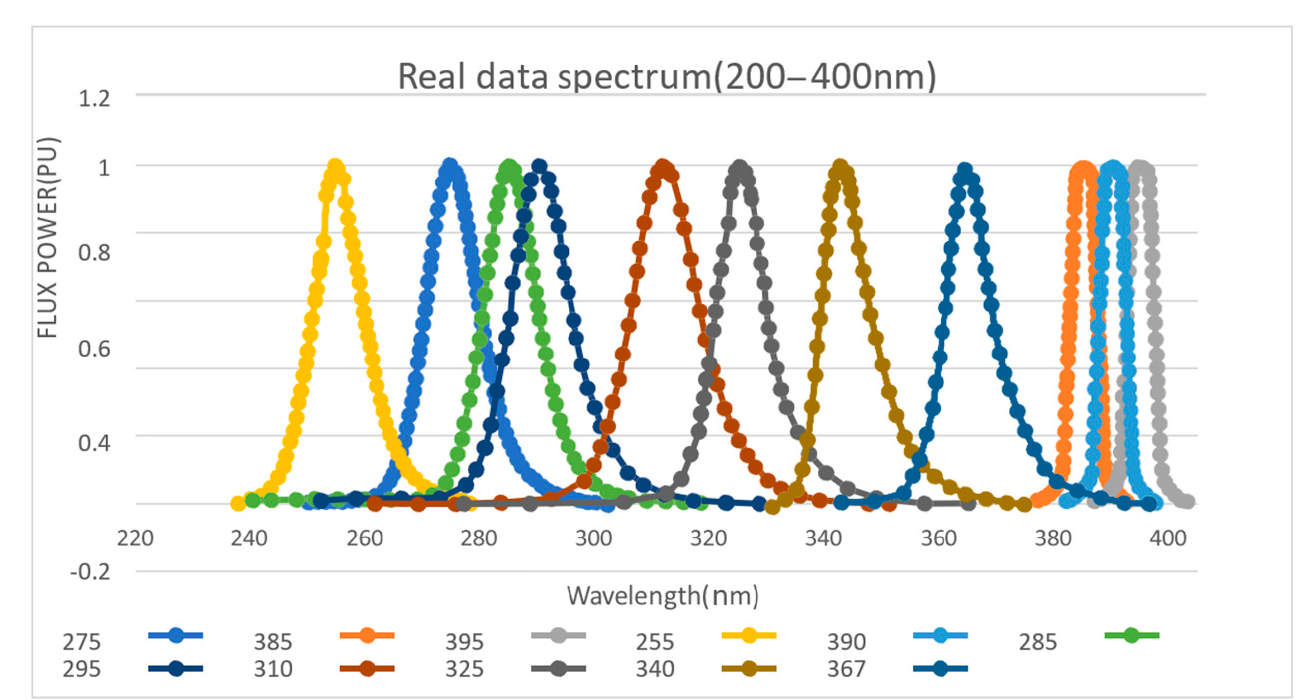
Figure 2. Light source